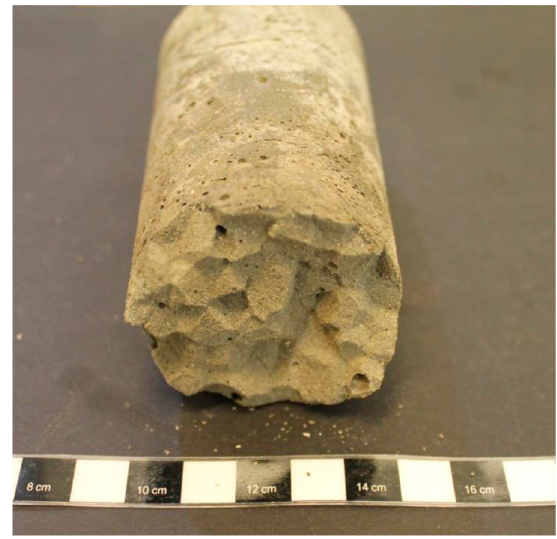
Figure 21. Sample created using Method VII after petrographic study.